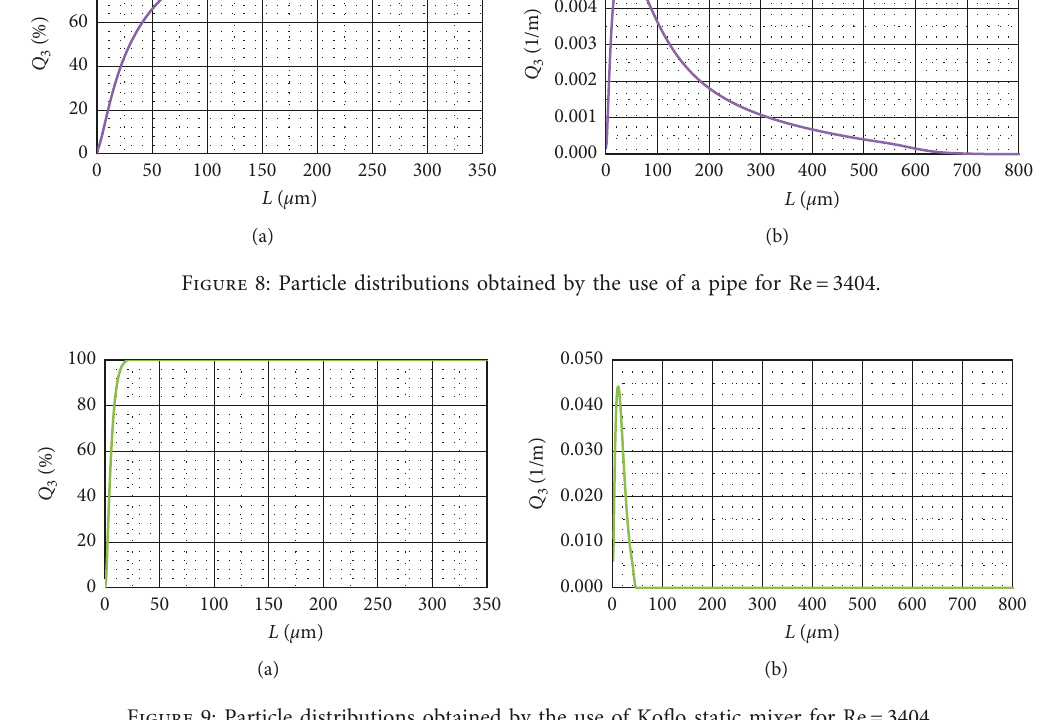
Figure 9: Particle distributions obtained by the use of Koflo static mixer for Re